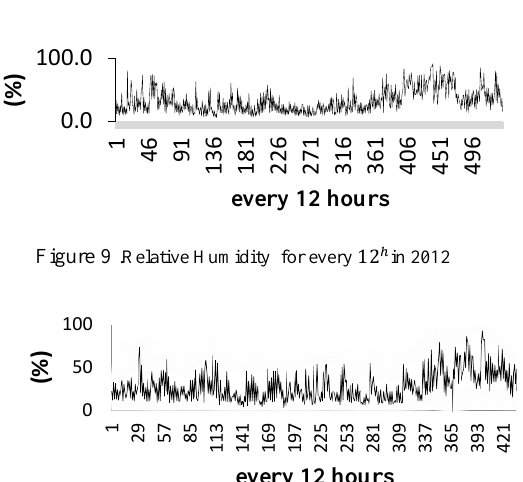
Figure 8 .Wind Direction for every 12 ℎ in 2013